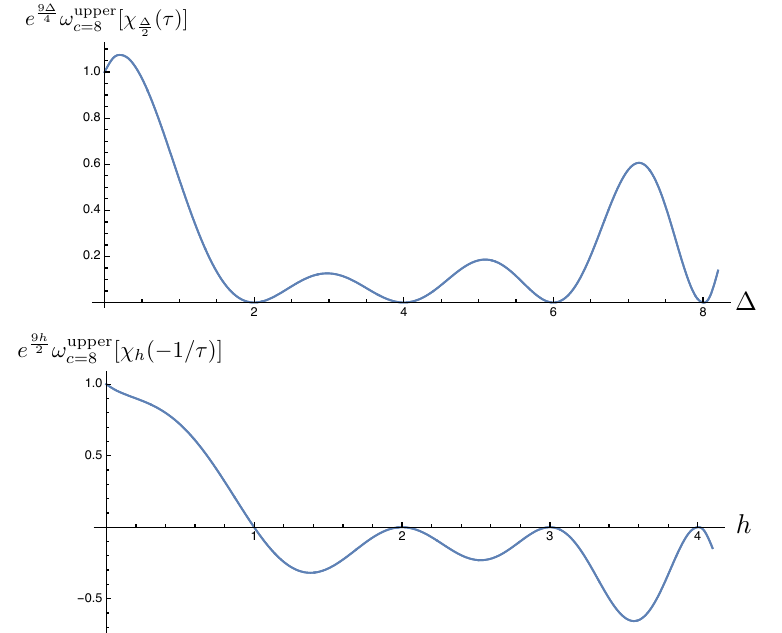
, defined in (5.2), on the bulk (upper c =8 [ χ ( τ )] and ∆ c =8 2